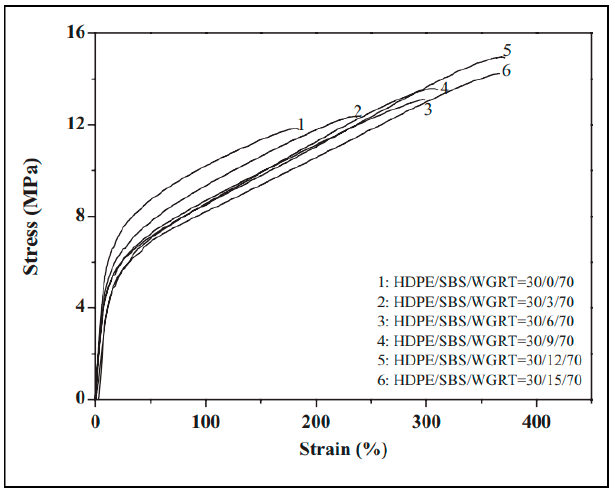
Figure 10. Typical stress-strain curves of high density polyethylene (HDPE)/GTR compounds compatibilized by styrene-butadiene-styrene (SBS) (reproduced with permission from [23]).